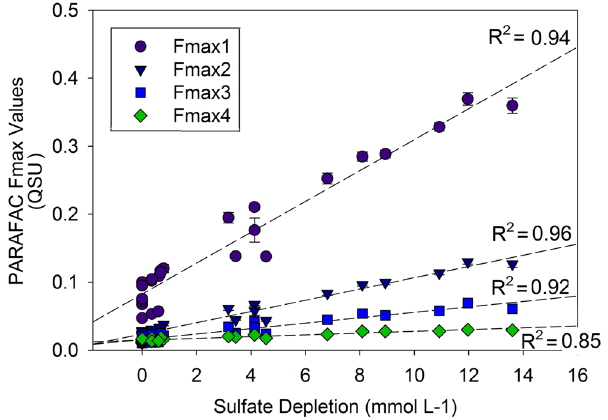
Figure 3. Sulfate depletion versus the intensity of individual PARAFAC components (Fmax1, Fmax2, Fmax3, Fmax4) in quinine sulfate equivalents (QSU) within each sample. A linear regression for each component is shown, error bars represent standard error of the mean. Standard error of slope: C1: 0.023 ± 0.001, C2: 0.0083 ± 0.00034, C3: 0.004 ± 0.00023, C4: 0.0013 ±